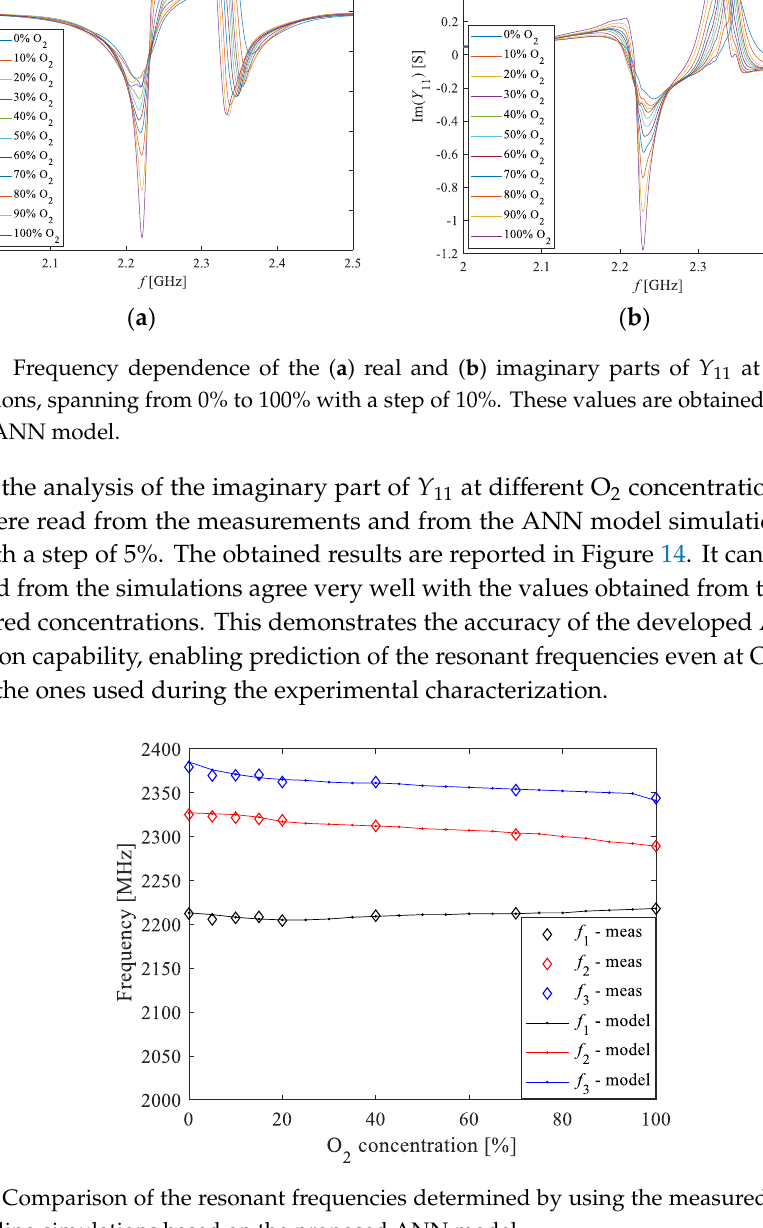
Figure 12. Frequency dependence and histograms showing the distribution of absolute values of the difference between the measured Y 11 and the corresponding values obtained by using the ANN model: ( a ) Y 11 real part; ( b ) Y 11 imaginary part.